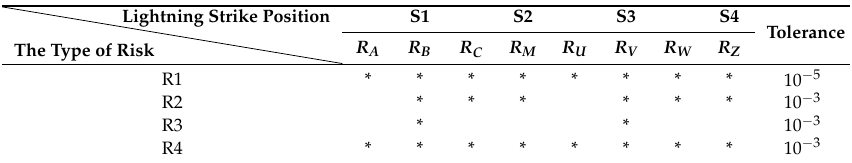
Table 1. The component of lightning risk value.